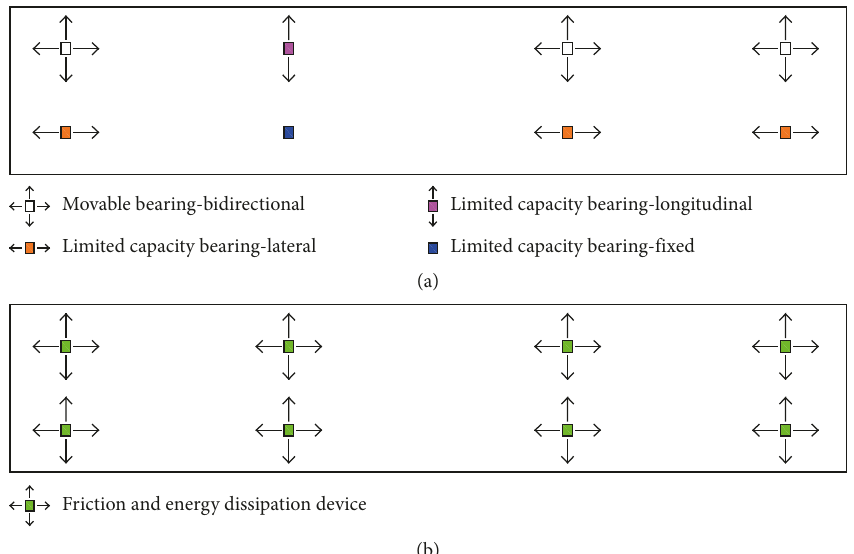
Figure 3: Support system for the continuous girder bridge under (a) normal and (b) earthquake